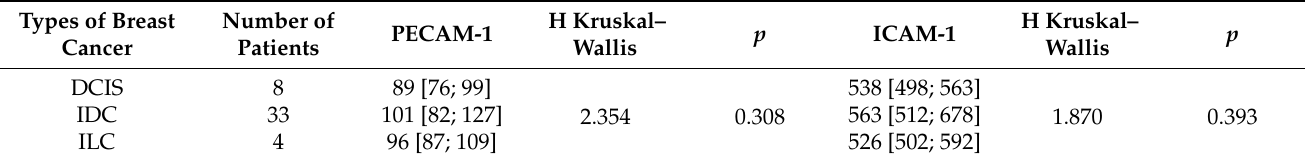
Table 6. Levels of adhesion molecules depending on histological type of breast